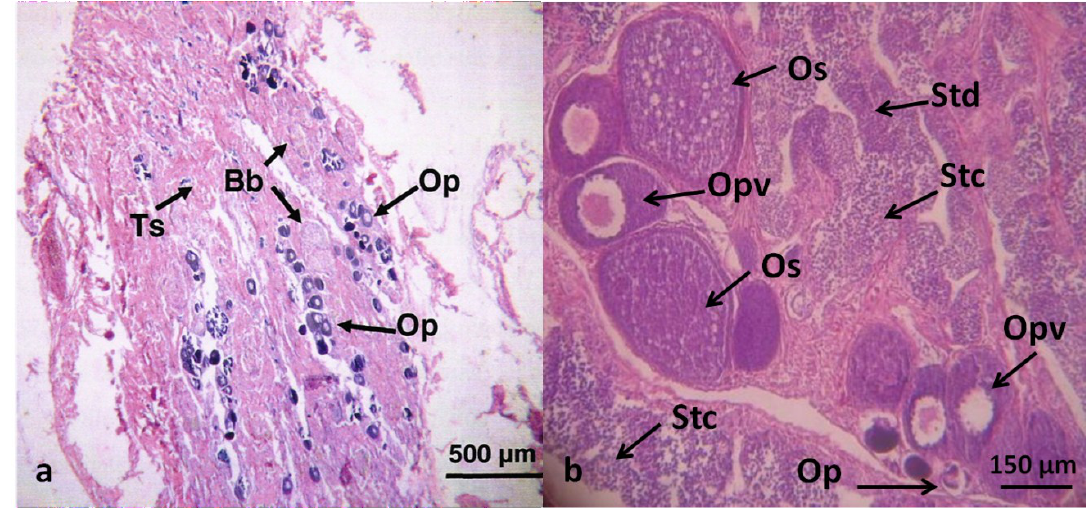
Figure 3. Micro-photographs of a typical testicular oocyte (intersex gonad), showing a mixture of ovarian and testicular elements. Ts: seminiferous tubules; Stc: spermatocytes; Std: spermatids; Sp: spermatozoids; Op: primary, Opv: previtellogenic and Os: secondary oocytes; Bb brown bodies.